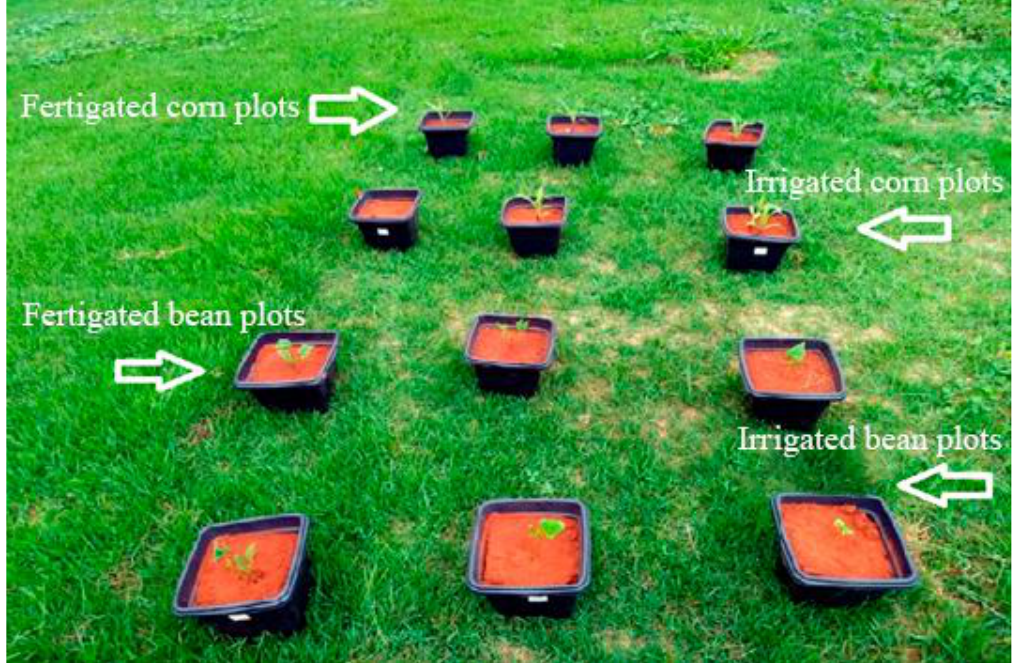
Fig. 1 Disposing of corn and bean pots (in